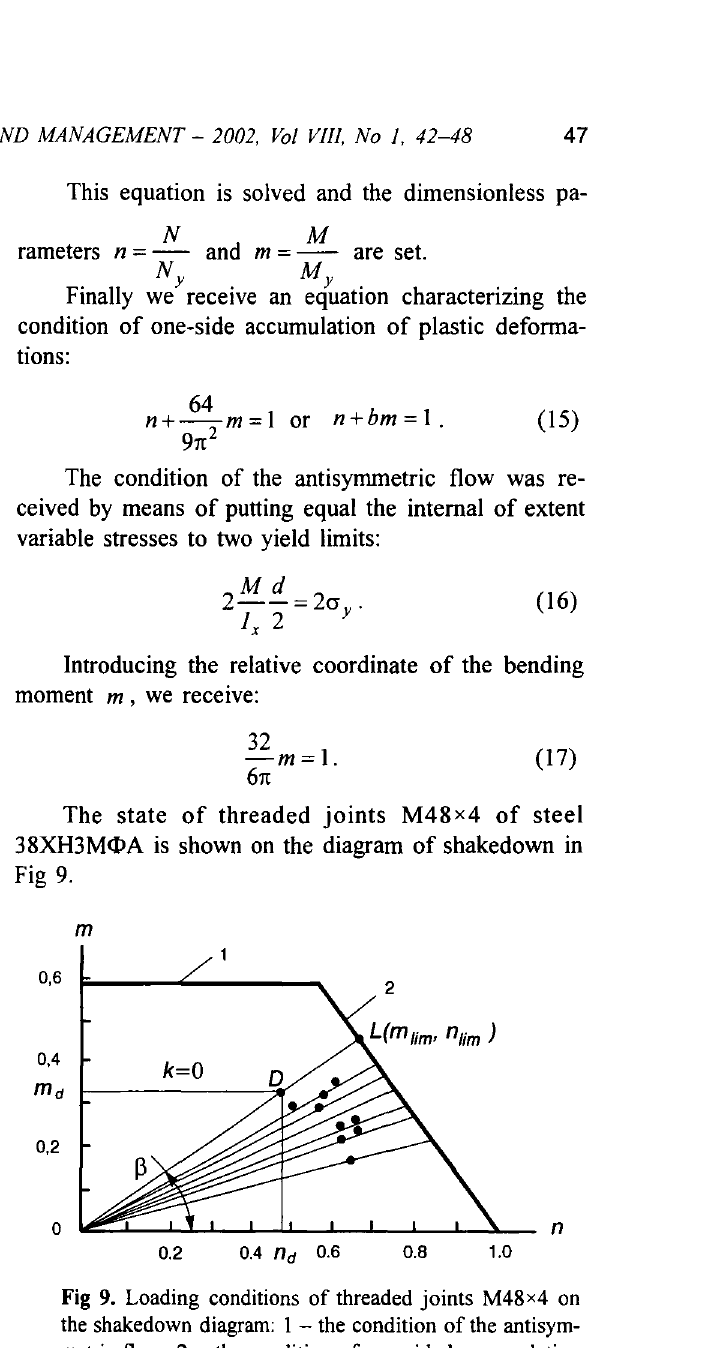
Fig 9. Loading conditions of threaded joints M48x4 on the shakedown diagram: 1 - the condition of the antisym metric flow; 2 - the condition of one-sided